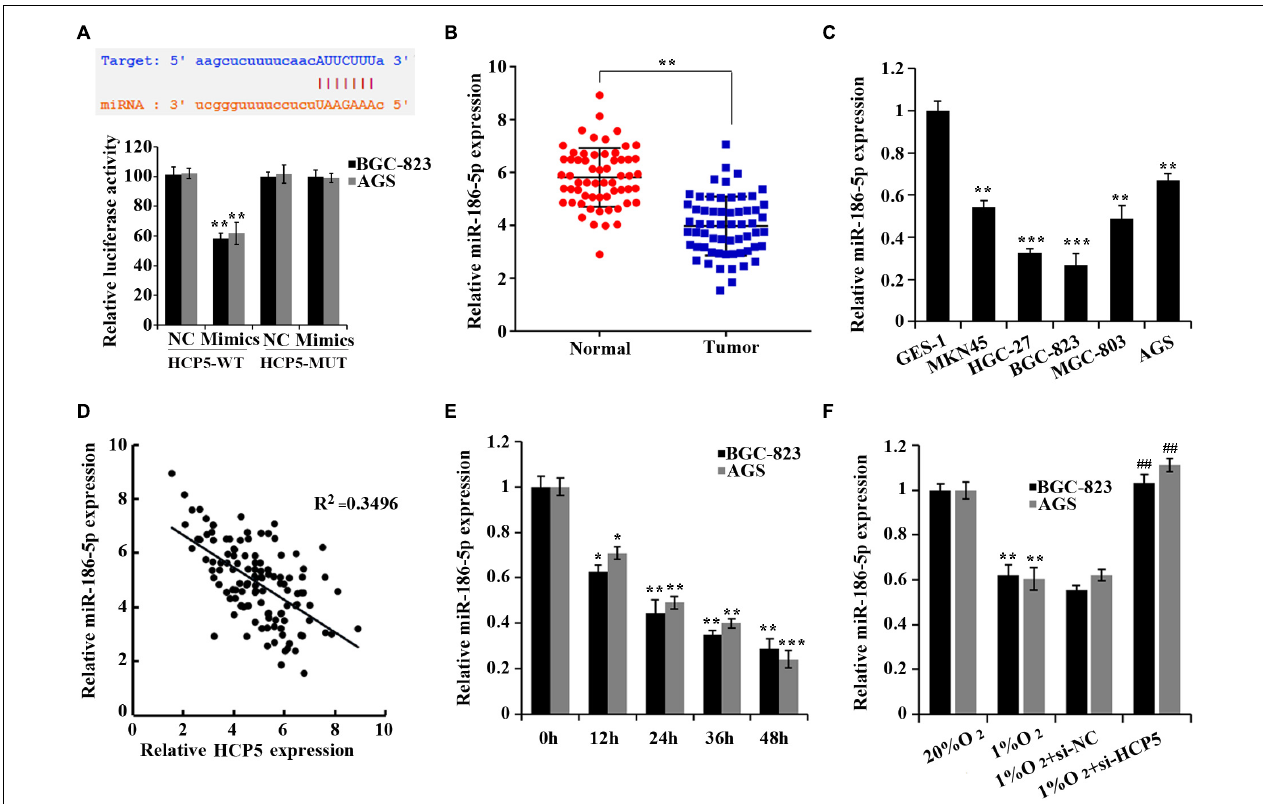
FIGURE 3 | HCP5 acts as a miR-186-5p sponge. (A) Dual-luciferase assay-based validation of the targeting relationship between HCP5 and miR-186-5p; ** p < 0.05 vs. NC group. (B) qRT-PCR-based detection of miR-186-5p expression in gastric cancer tissues and matched normal counterparts; ** p < 0.01. (C) qRT-PCR-based detection of HCP5 expression in cells; * p < 0.05, ** p < 0.01, *** p < 0.001 vs. GES-1 cells. (D) Pearson correlation analysis of HCP5 and miR-186-5p in gastric cancer tissues. (E) qRT-PCR analysis of HCP5 expression in BGC-823 and AGS cells at different time points of hypoxia; * p < 0.05, ** p < 0.01, *** p < 0.001 vs. 0 h group. (F) qRT-PCR analysis of miR-186-5p expression in BGC-823 and AGS cells, ** p < 0.01 vs. 20% O 2 group; ## p < 0.01 vs. 1% O 2 +